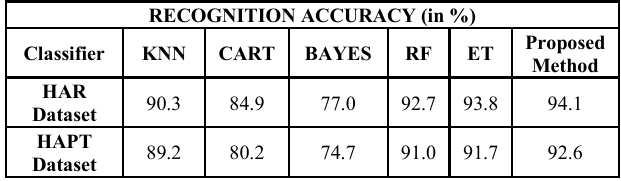
Figure 4. Recognition accuracies of proposed approach with existing techniques using HAR dataset